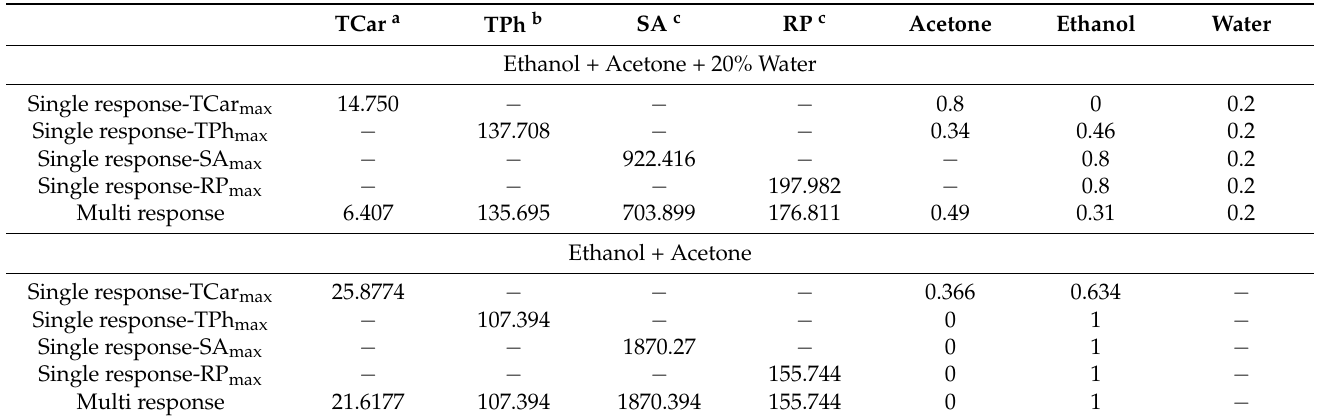
Table 3. Single and multi-response optimization of extraction solvent mixtures.